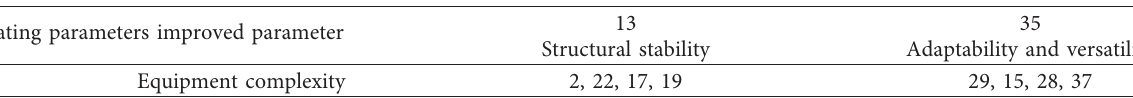
Figure 1: Nine-screen analysis of the vibrating Table 1: Conflict matrix.